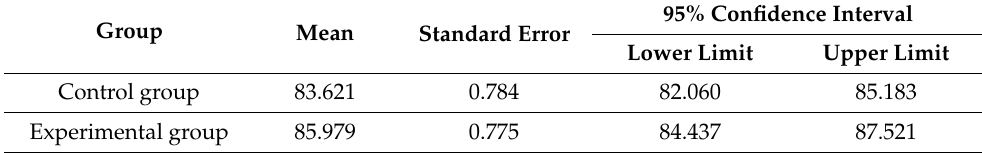
Table 11. Marginal mean and standard